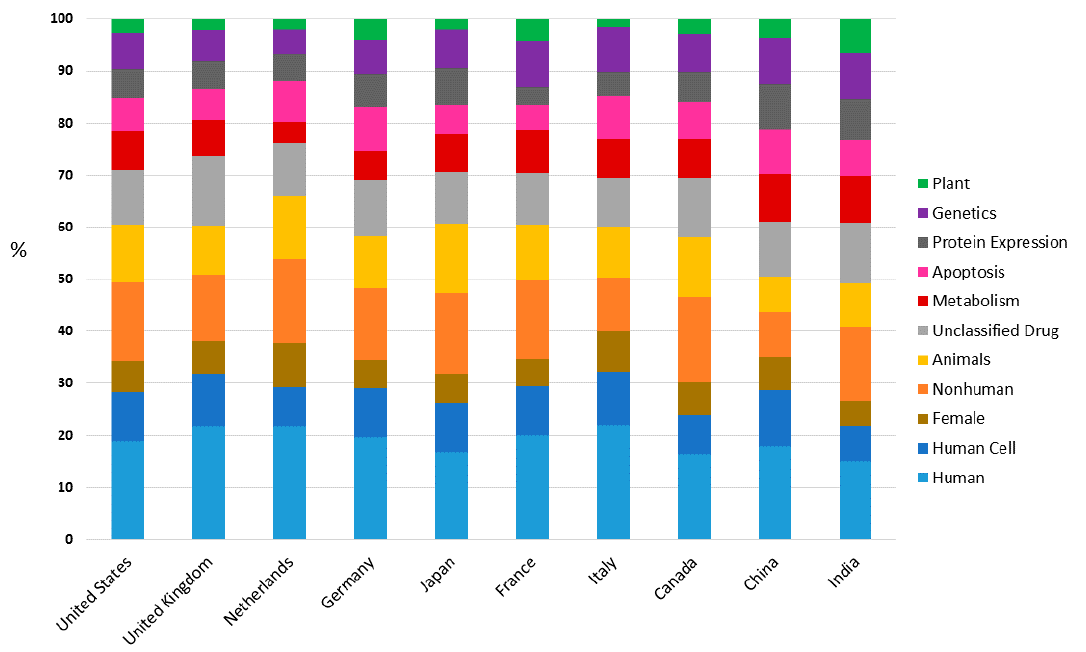
Figure 6. Distribution of main keywords by country as percentage of their own publications.